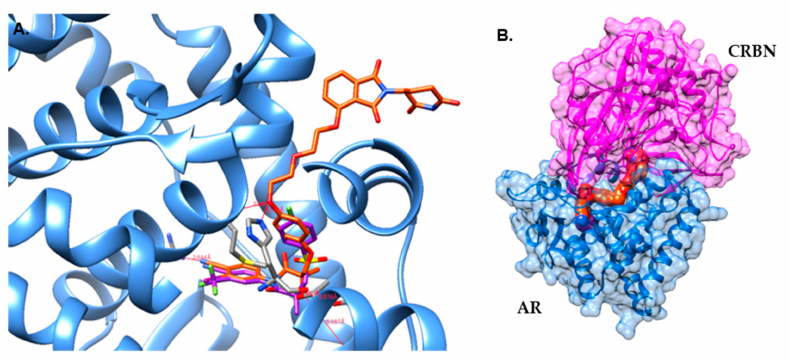
Figure 6. ( A ) Superposition of 13b (orange) with ( R )-bicalutamide (purple) bound to androgen receptor (AR, PBD code: 1Z95). The interacting residues are shown in gray. ( B ) Cartoon representation of the ternary complex of 13b (orange) with AR (PDB Code: 1Z95) and CRBN (PDB Code: 4CI3), which were visualized using Chimera 1.10 (UCSF